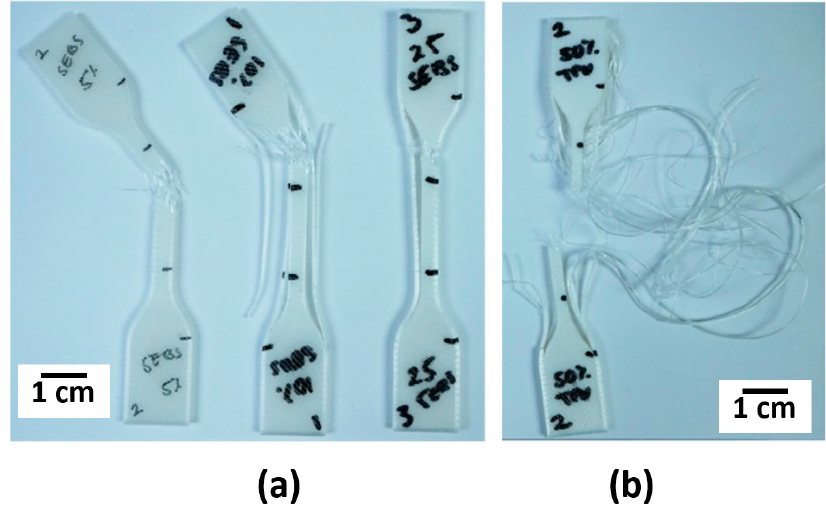
Figure 11. Examples of delamination of a FFF specimens fabricated in a 45° raster patterns in the case of ( a ) PLA:SEBS blends and ( b ) PLA:TPU.